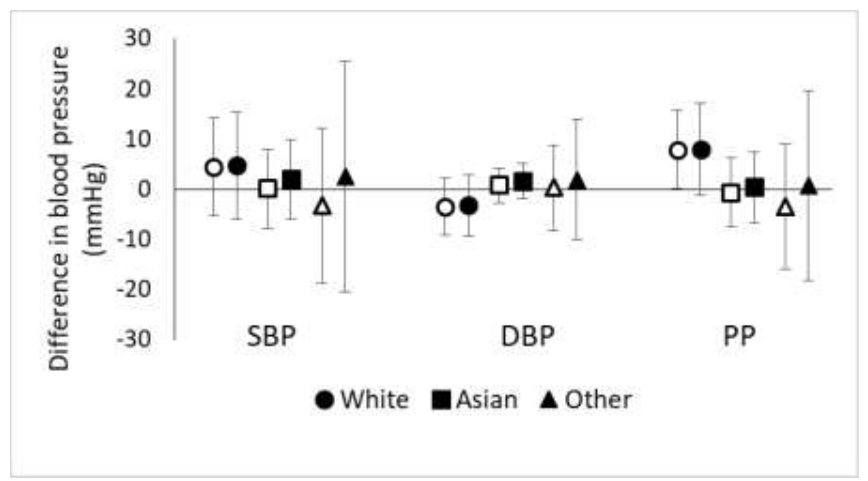
Figure 2. Effect modification of the association of ln(TAA-PNC) with blood pressure by race/ethnicity. Open markers represent unadjusted associations (Model A) while solid markers represent adjusted associations (Model B; adjusted for BMI, sex, smoking, physical activity, and diet as fried food consumption).